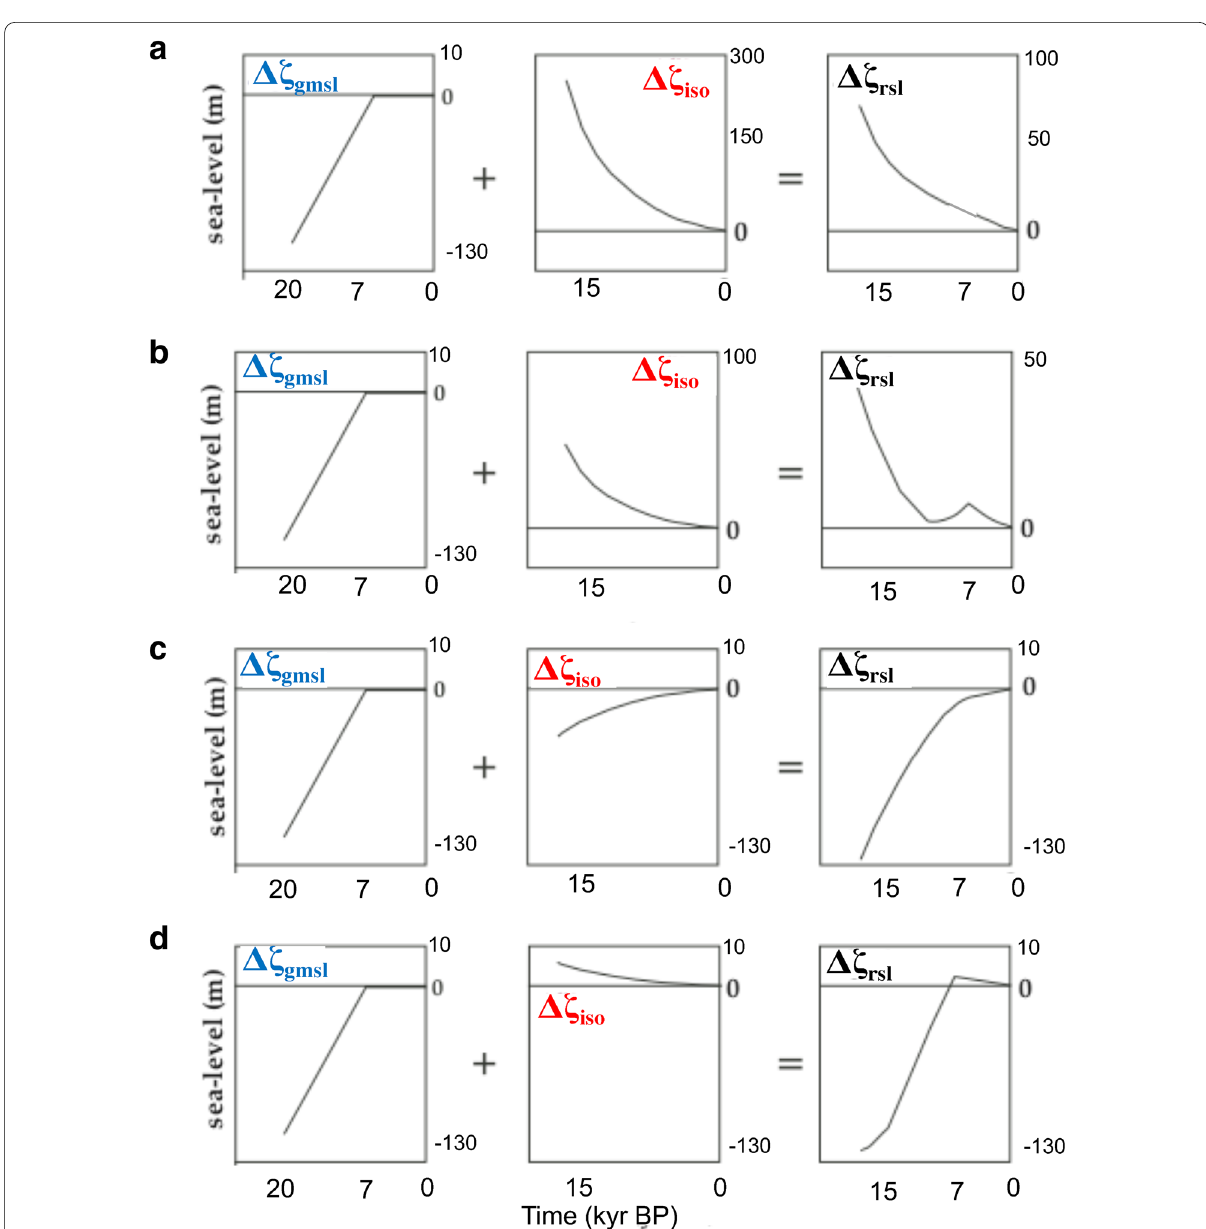
Fig. 8 Schematic diagram showing the relations between relative sea level, global mean sea level and isostasy in a near-field (within the region formerly occupied by an ice sheet—but away from the ice sheet margin), b the near-field (close to the margin of the former), c the intermediate-field and d the